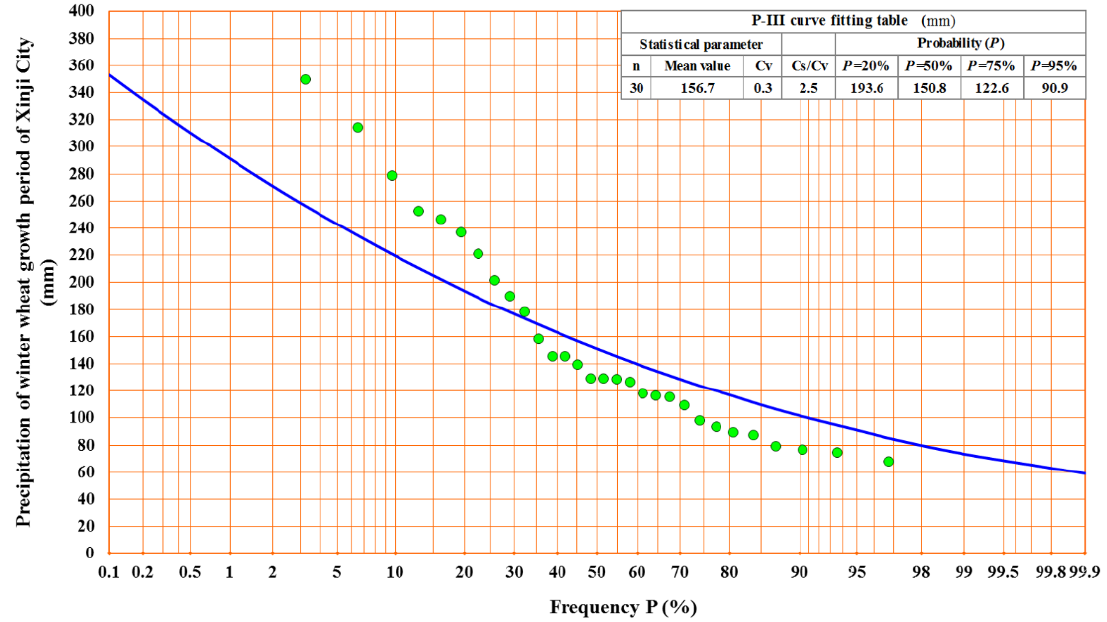
Figure 2. Pearson- Ⅲ frequency curve of rainfall in the growth period of winter wheat in Xinji city for nearly 30 years.